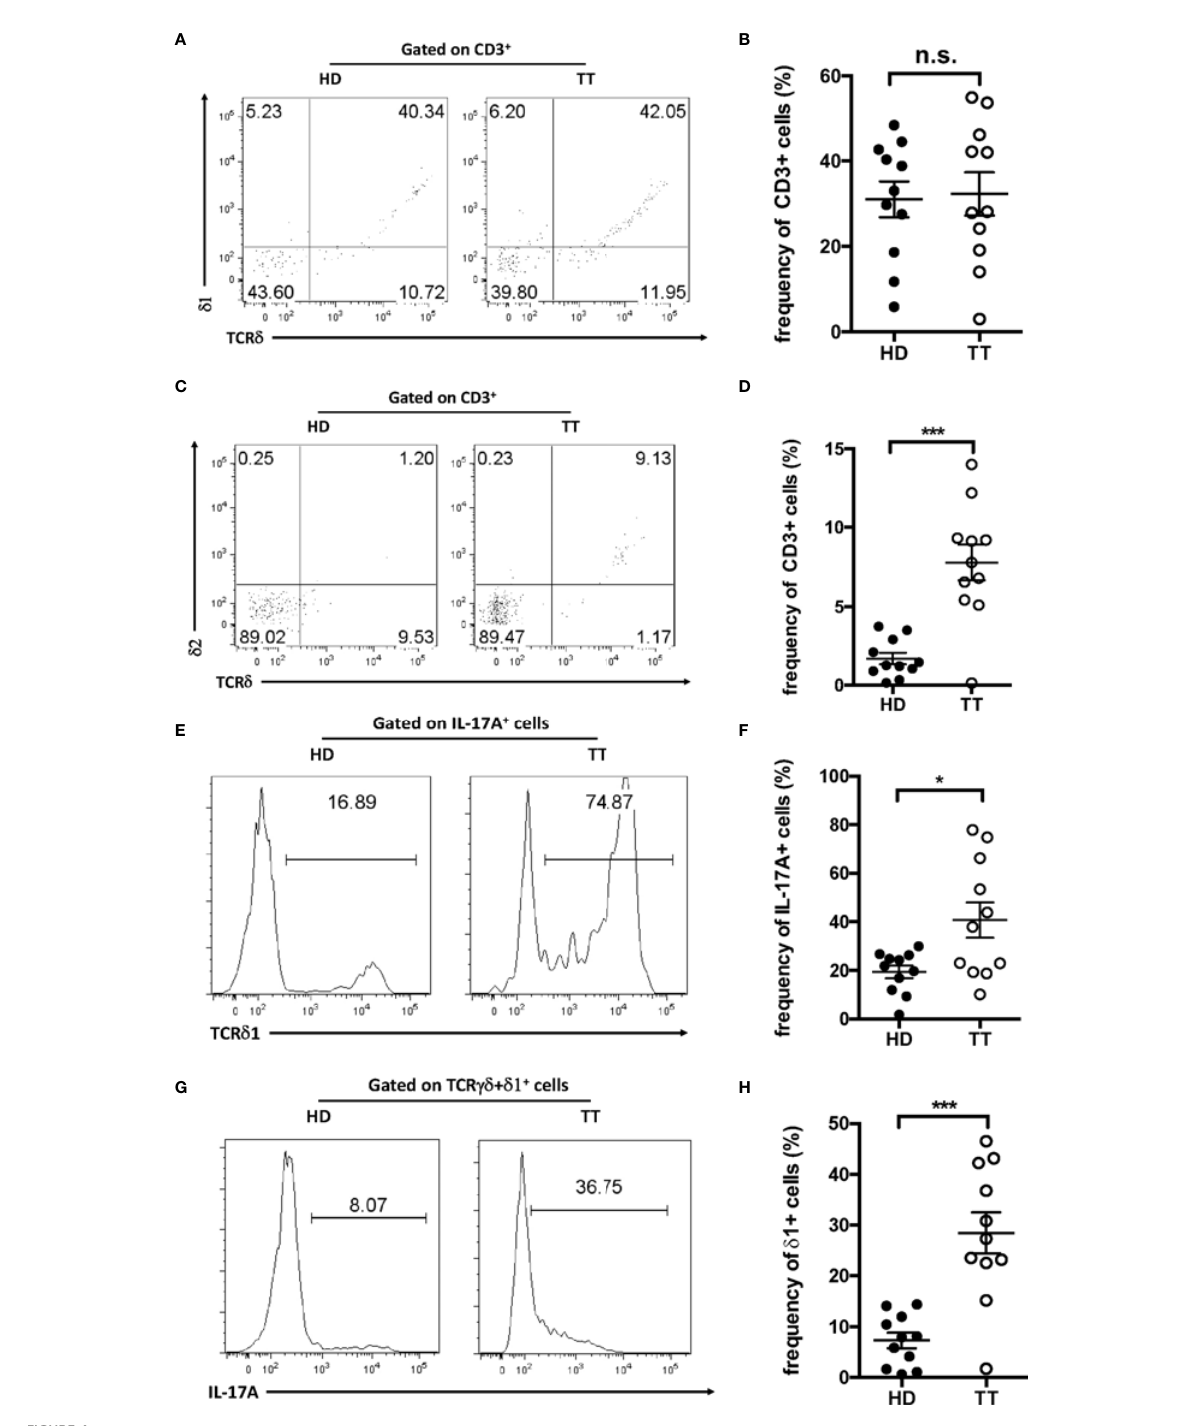
FIGURE 4 TCR usage of dermal gd T cells. Dermal cell suspensions were stained with V d 1 (A) and V d 2 (C) and analyzed with fl ow cytometry. Flow plots gated on CD3 + cells. (B) Statistical results in (A) . (D) Statistical results in (C) . (E) Histogram of V d 1 + cells among IL-17 + dermal cells from leprosy lesions or healthy skin. (F) Statistical results in (E) . (G) Histogram of IL-17A – producing cells among dermal V d 1 + cells from leprosy lesions or healthy skin. (H) Statistical results in (G) . Percentage was shown as mean ± SEM. Statistical analysis was performed by t -test. n.s.: no signi fi cance; * p < 0.05; *** p <